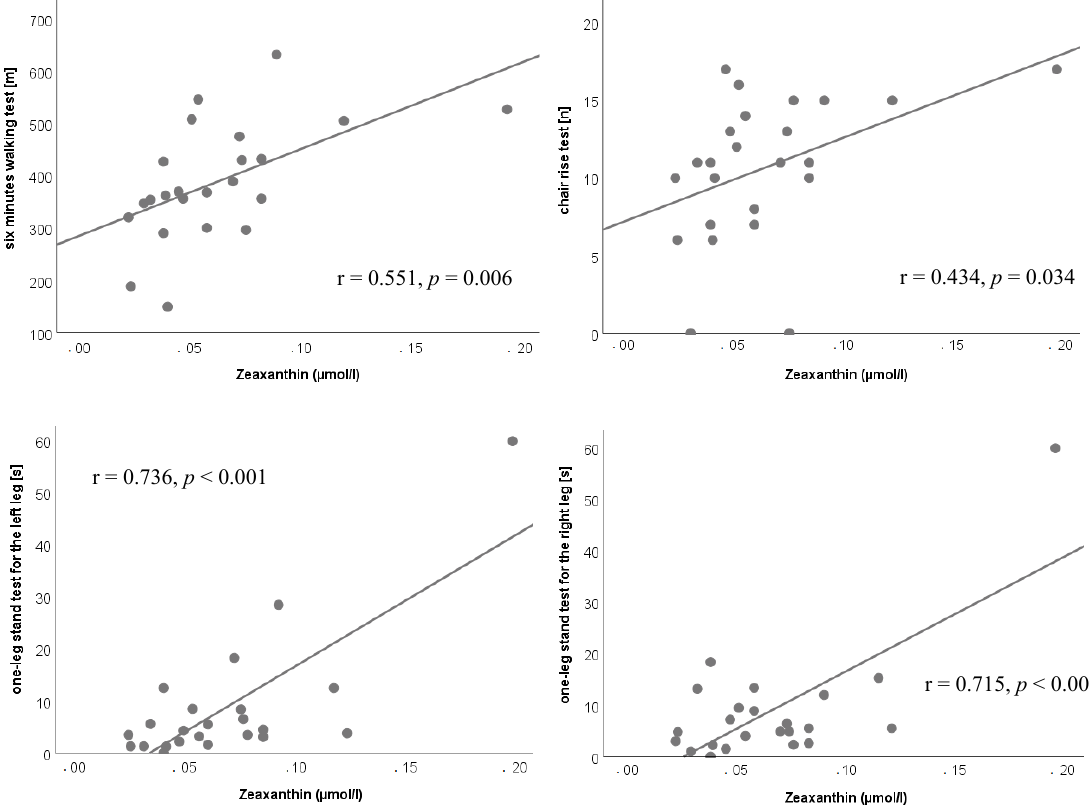
Figure 3. Correlations after 6 months of intervention in the control (CT) group.